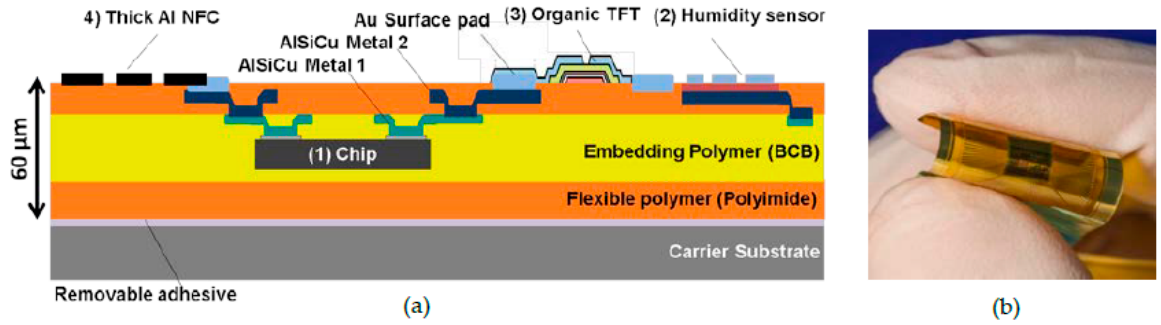
Figure 2. The Chip-Film Patch (CFP) technology. ( a ) Schematic of the foil technology enabling the ultra-thin sensor system. ( b ) Embedded 20-µm thick silicon chip.